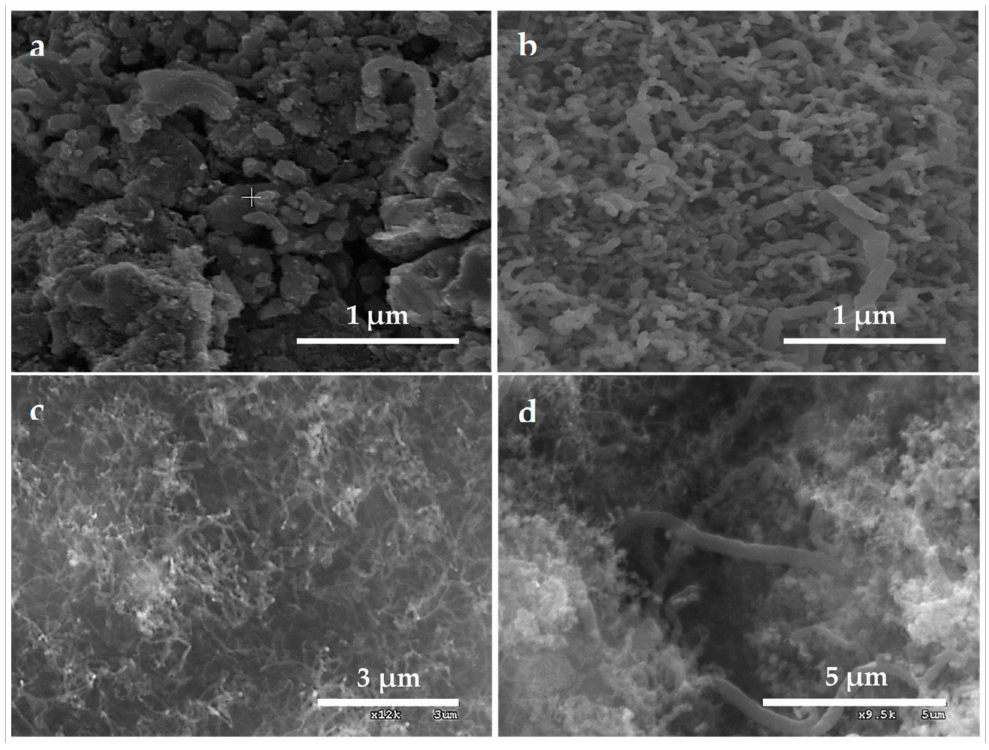
Figure 4. SEM images of hybrid samples: ( a ) C@Al-723; ( b ) C@Al-823; ( c ) C@Al-923; ( d ) C@Al-1123. Table 3. Main data for the Raman spectra of the hybrid